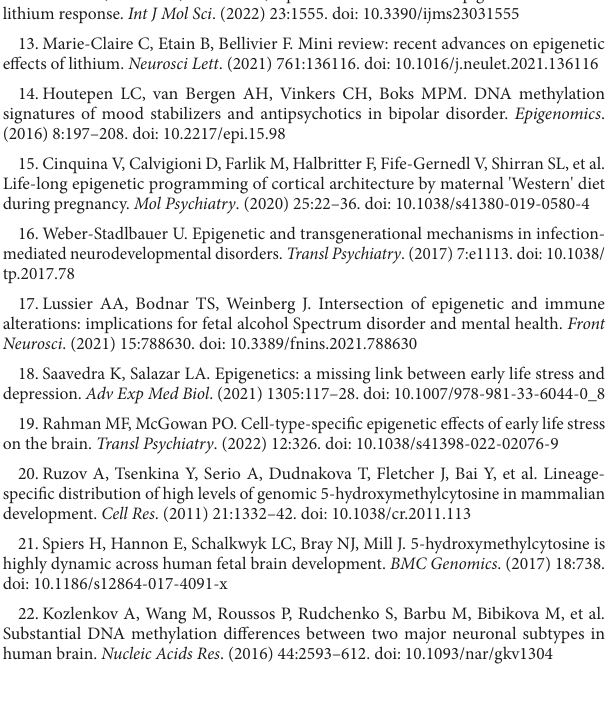
SUPPLEMENTARY FIGURE 1 Fluorescence microscopy images of (a) iPSCs and (b) NSCs demonstrating pluripotency (iPSC markers Oct4, Sox2 and NANOG; NSC marker Sox2) and early neuronal lineage (NSC markers Nestin and SSEA-4). SUPPLEMENTARY FIGURE 2 Scatterplot of test scores generated from classical paired t -tests and moderated t -tests (limma) that compared iPSC and NSC 5hmC expression levels. SUPPLEMENTARY FIGURE 3 (a) Student’s t quantile-quantile (Q-Q) plot for results from t -tests comparing VOOM-adjusted 5hmC counts NSC cell lines between BD cases and unaffected sibs; and (b) volcano plot of differential 5hmC expression (log base 2 FC; log base 10 t -test P -values) between BD cases and unaffected sibs for NSC cell lines (downregulation defined as FC < -1 and P < 0.05; upregulation defined as FC > 1 and P <